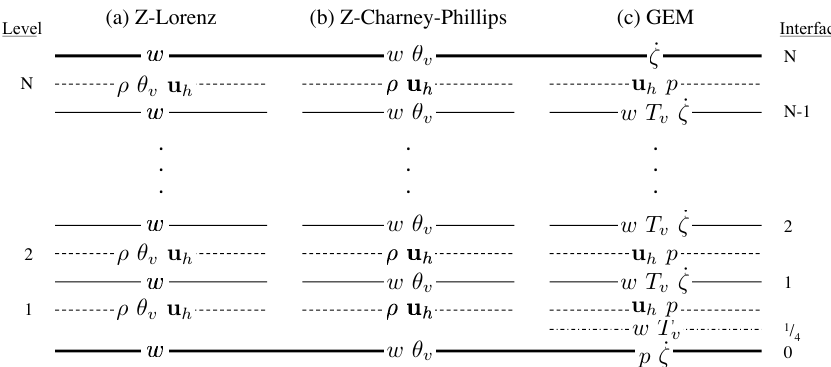
Figure 7. (a) A Lorenz-type variable staggering for a model utilizing height coordinates, (b) a Charney–Phillips-type variable staggering for a model utilizing height coordinates, and (c) a modified Charney–Phillips-type staggering used in the GEM model that introduces a new near-surface level for vertical velocity and